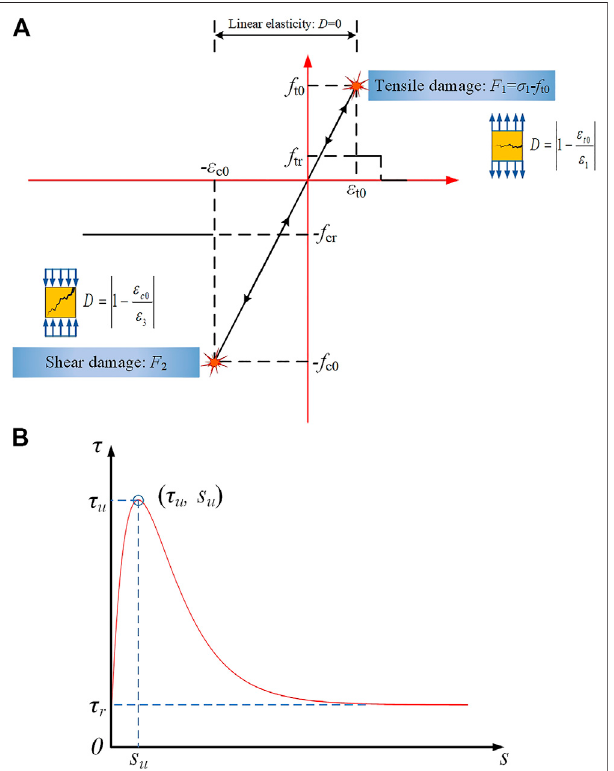
FIGURE 9 | Governing equations: damage model for rock elements at the mesoscale (A) and nonlinear shear-slipping model of an anchoring interface (B) .